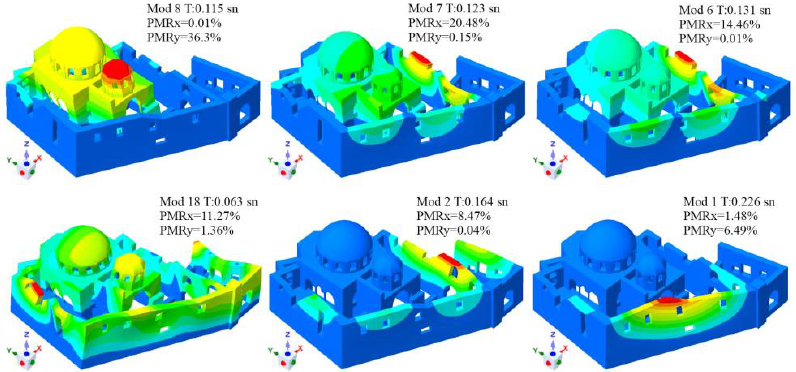
Figure 14. Eigenfrequency analysis results.